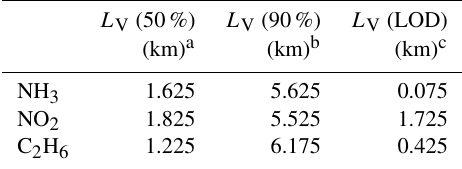
Table 7. Variability length scale of NH 3 , NO 2 and C 2 H 6